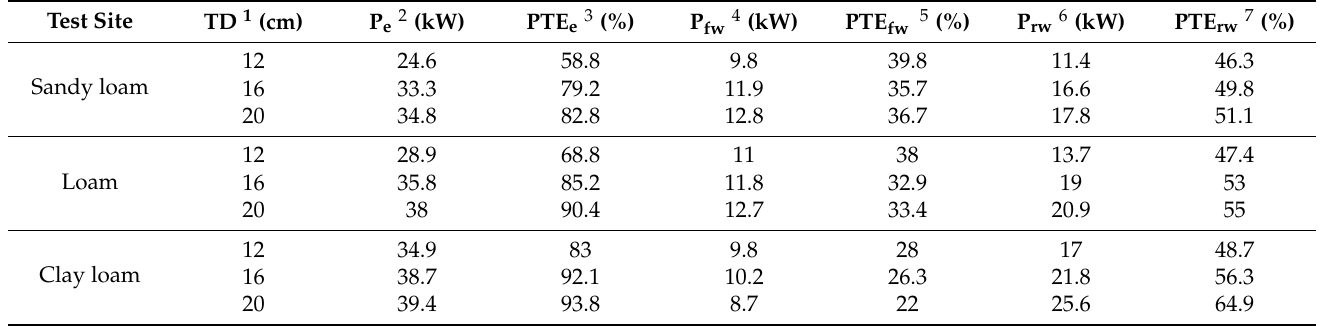
Table 7. Results of power transmission efficiency by tillage depth and test sites.